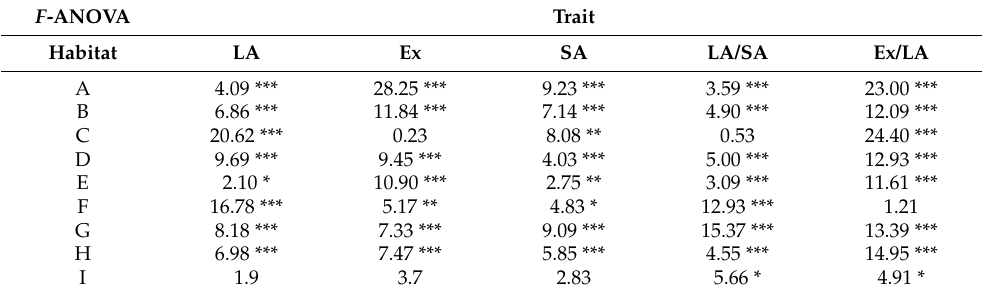
Table 7. F -statistic value from one-way analysis of variance for a comparison of samples in particular habitats for five quantitative traits, A–I abbreviated habitat names (see: Table 1).